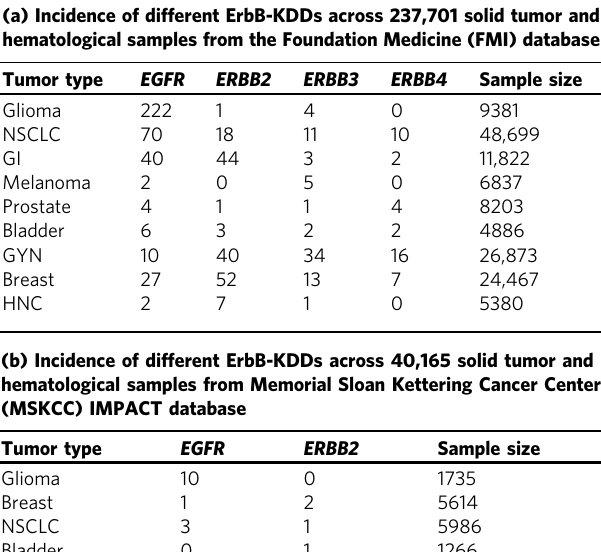
Table 1 Incidence of ErbB family kinase domain duplications (KDDs) across tumor